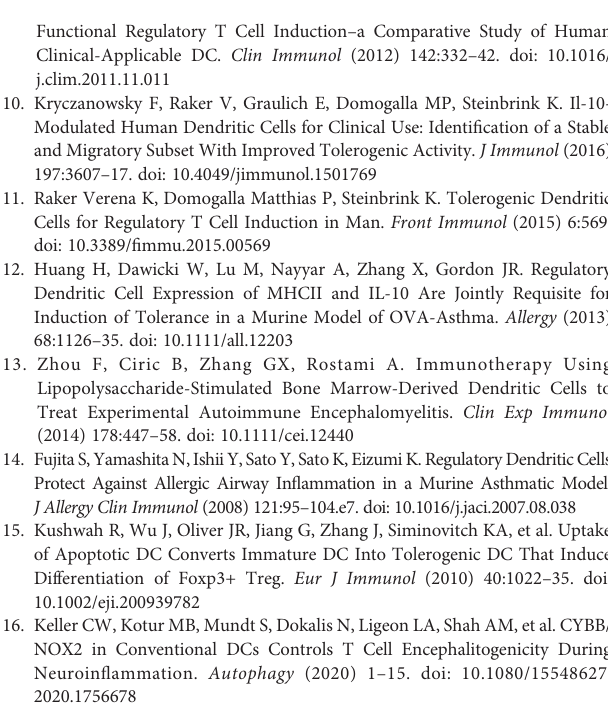
Supplementary Figure 1 | Generation and characterization of bone marrow derived dendritic cells (BMDCs). (A) BM cells were cultured in RMPI-1640 medium with 10% FCS and 20ng/mL GM-CSF for 9 days. After incubation with PBS, 50ng/ mL IL-10 or10ng/mL LPS for 24hrespectively, cells were stimulated with1 m M OVA for 2h, and DC ia, DC 10 and DC lps were collected. (B) BMDCs were fi rst gated on CD11c and MHCII cells, and then the expression of CD80 and CD86 evaluated on CD11c + MHCII + cells by FCM. Negative control was shown in upper panel. Supplementary Figure 2 | Central and effector memory T cells were fi rst gated on CD4 and CD44 cells, and then the expression of CD62 and CCR7 evaluated on CD4 + CD44 + cells by FCM. Central memory CD4 + T cells (T CM ) were determined as CD4 + CD44 + CD62 + CCR7 + memory T cells. Effector memory CD4 + T cells (T EM ) were determined as CD4 + CD44 + CD62L - CCR7 - memory T cells. Supplementary Figure 3 | Gating strategy of CD4 + CD25 + Foxp3 + Tregs were shown in the representative FCM dot plots. Pulmonary Tregs were fi rst gated on CD4 and CD25 cells, and then the expression of Foxp3 evaluated on CD4 + CD25 + cells by FCM. Supplementary Figure 4 | Representative Masson staining of airway and parenchyma (scalebar = 100 m m, Massonstaining showedthat collagen fi bers appearedblue and muscle fi bers appeared red). Percentage of the blue collagen- positive area inairway ineach group. The columns anderror barsrepresent the mean and SEM.(ns = nosigni fi cant difference, ANOVA with Tukey ’ s post hoc analysis).The same experiment was repeated 3 times with similar results (n= 5 ineach